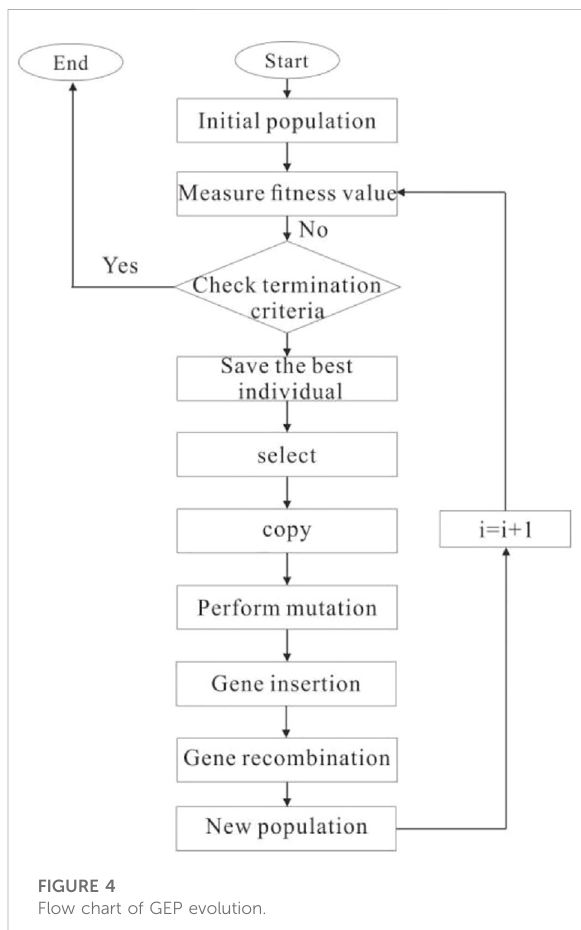
FIGURE 4 Flow chart of GEP evolution.